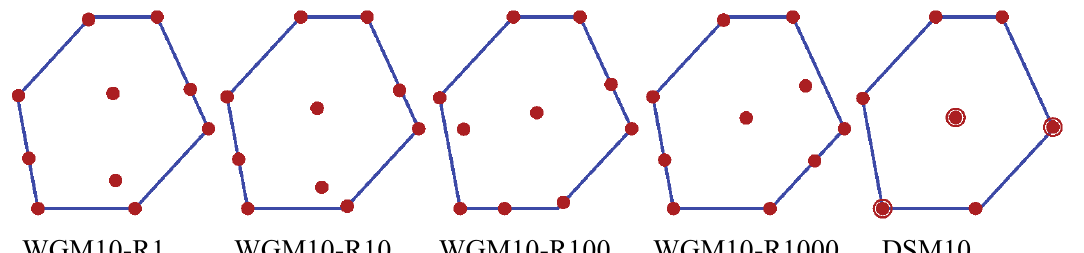
Fig. 3. The competing designs for Snee’s experiment. and represent 1 and 2 replicates of that design point,